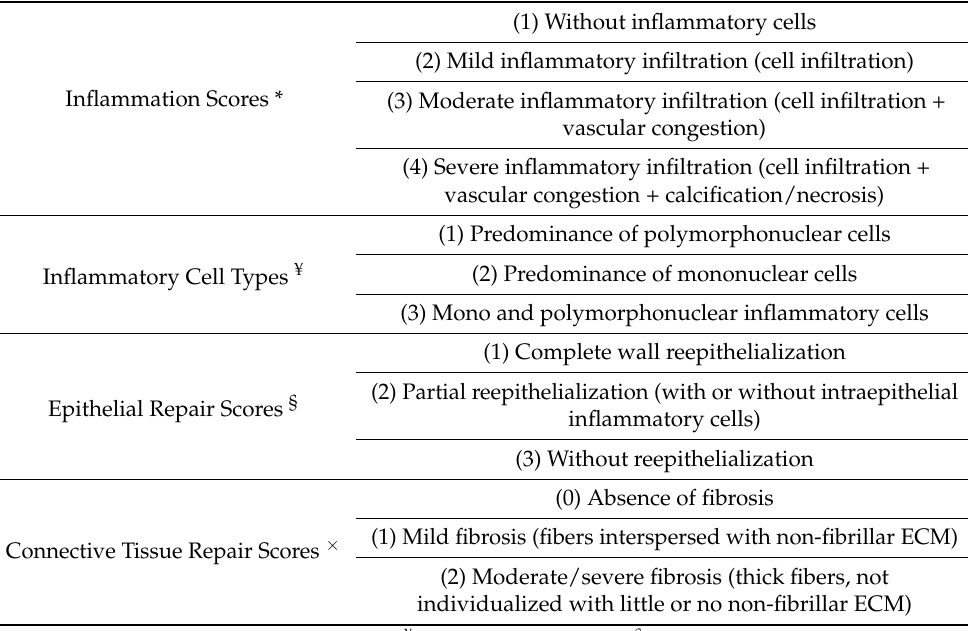
Table 1. Post-Surgical Repair